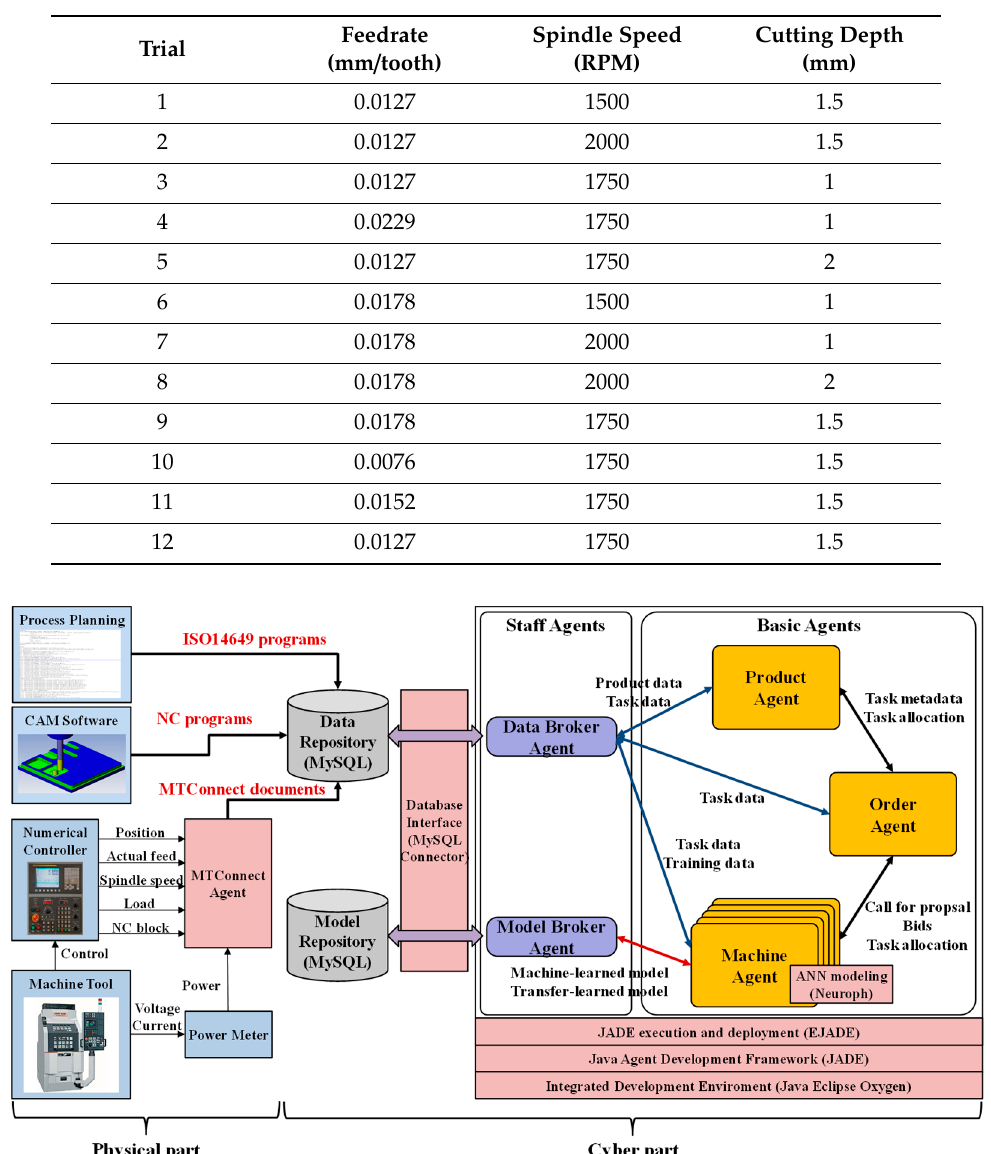
Figure 12. Implementation architecture of the prototype system.